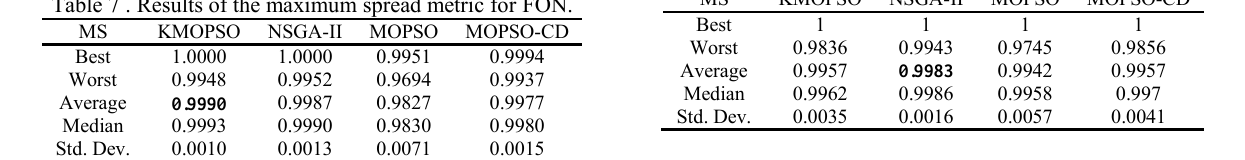
Table 10 . Results of the maximum spread metric for POL